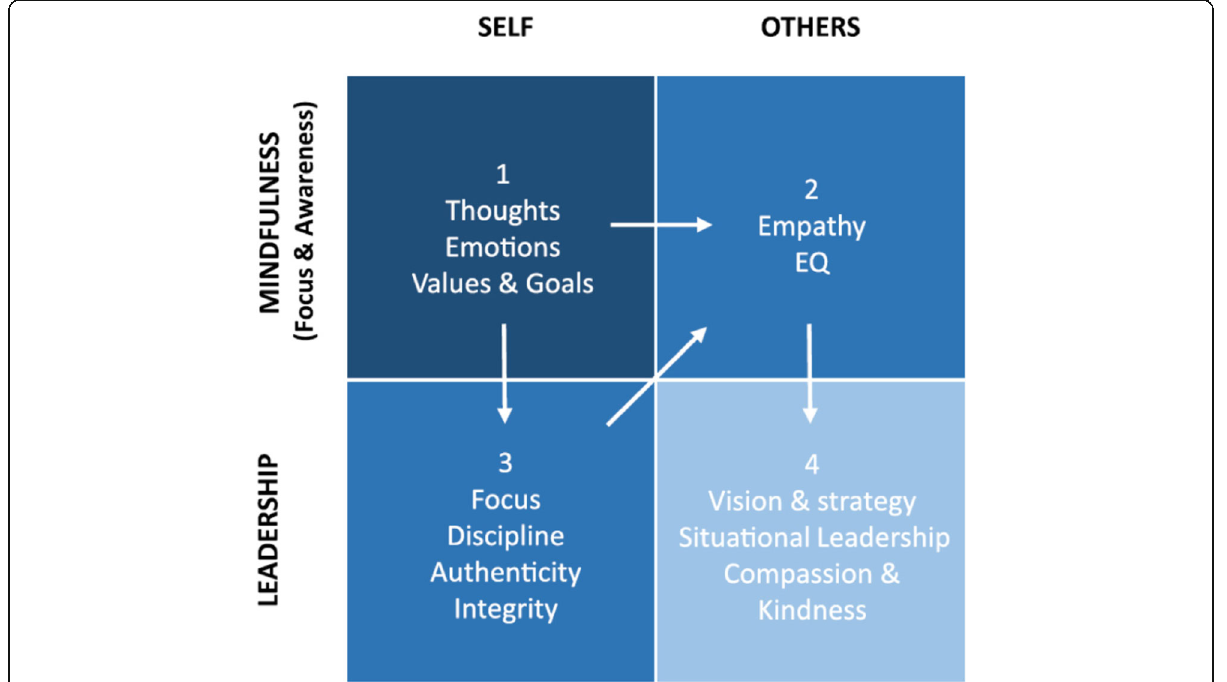
Fig. 3 Mindful Leadership Framework. Source: Rasmus Hougaard, etc. 2016, Mindful Leadership: Achieving Results by Managing the